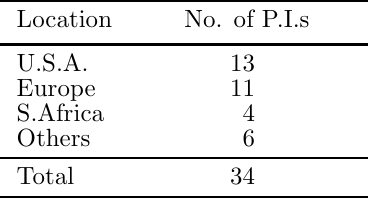
Table 3. Home institutions of the WET Principal Inves-